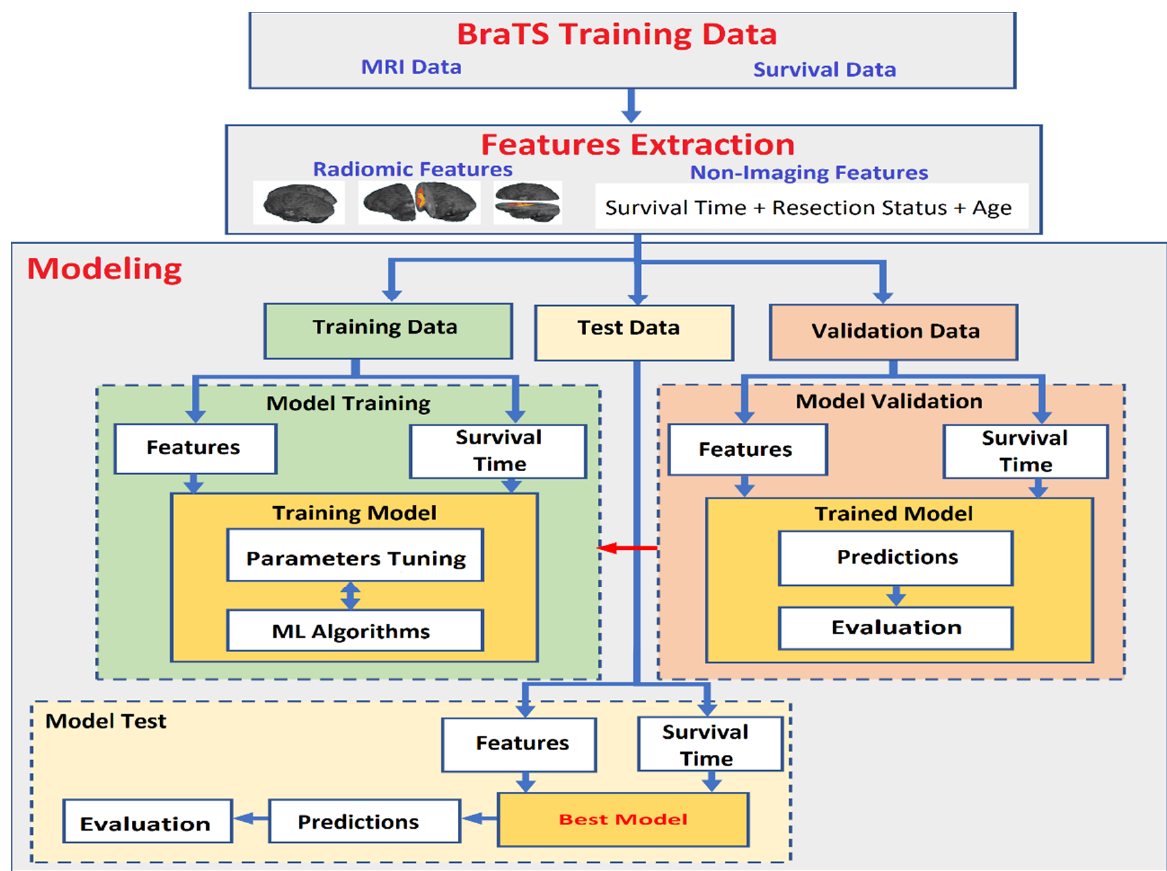
Figure 1. Steps to develop the overall survival time prediction system for glioblastoma patients.